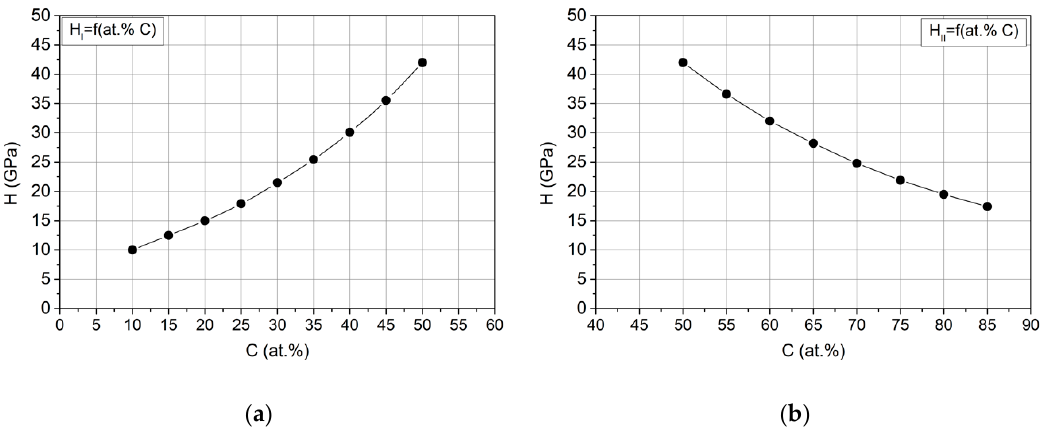
Figure 3. Hardness change profiles for coatings in carbon concentration ranges of 0–50 at.% ( a ) and 50–85 at.% ( b ), determined with the use of Formulas (1) and (2) on the basis of experimental data contained in [15].